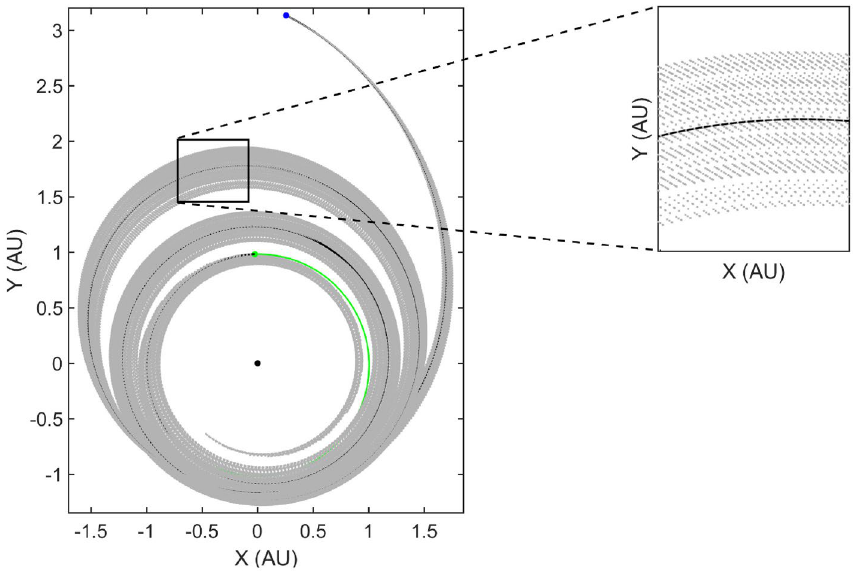
Figure 6. 6D spacecraft states from the time-optimal bundle represented as time slices on a 3D plot.